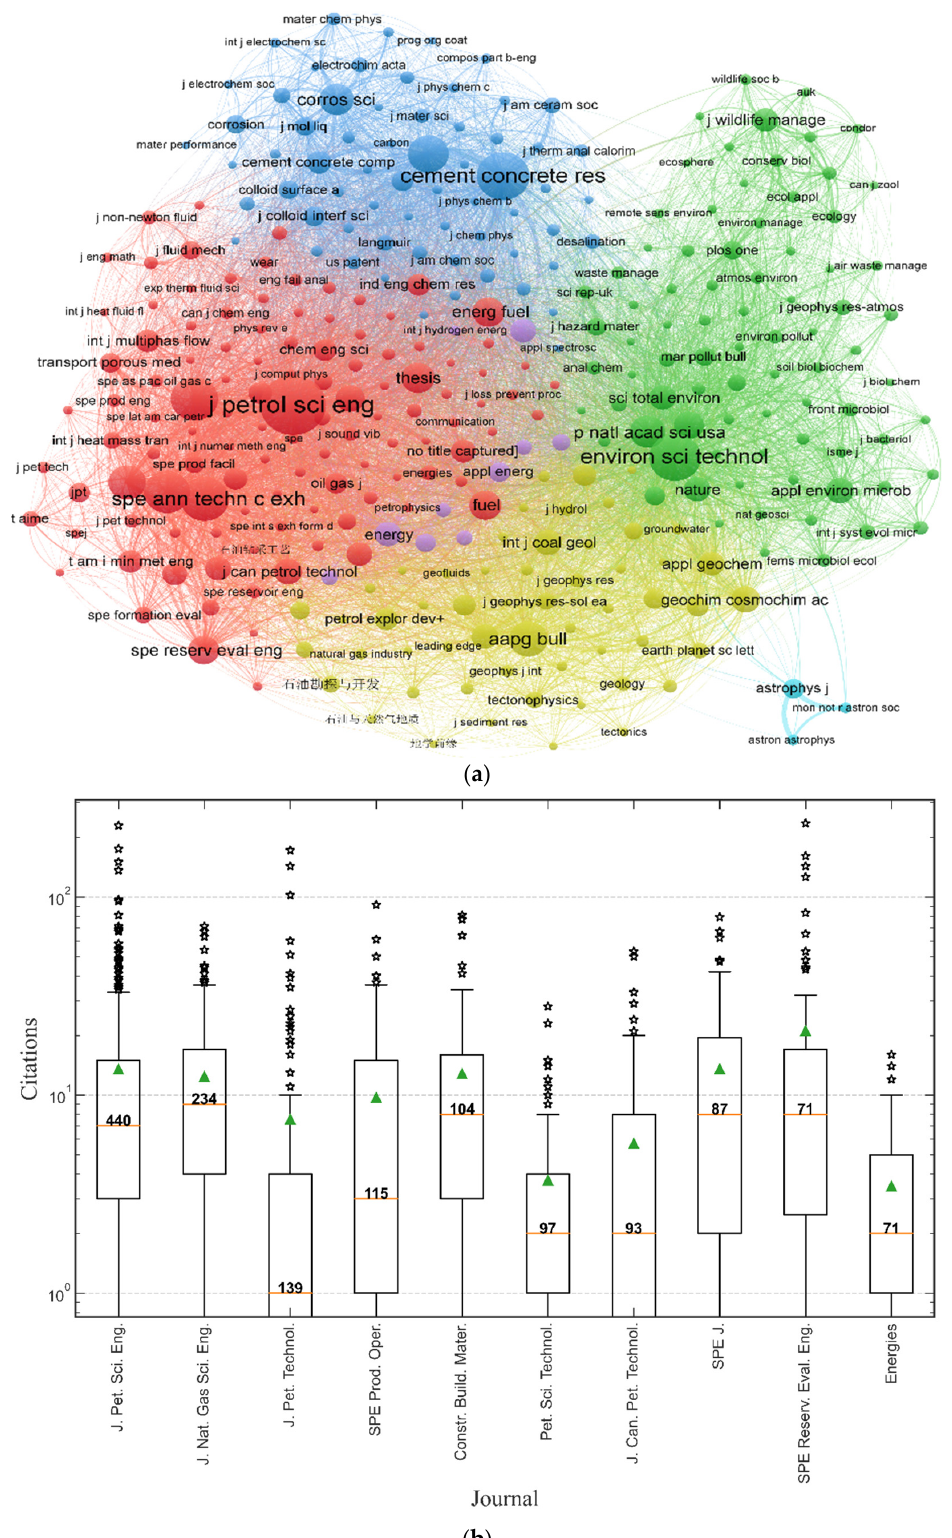
Figure 12. ( a ) The giant connected component of journal co-citation network of oil and gas wells research between 1992 and 2021 generated by VOSviewer. ( b ) Top 10 most scientific influence journals. The asterisk in figure indicates the outliers.